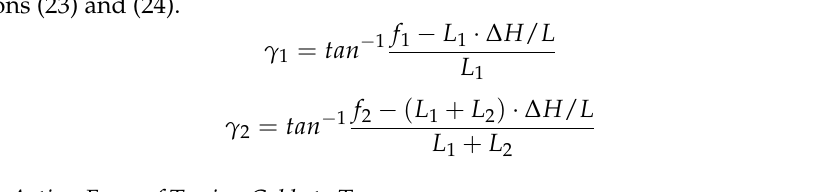
Figure 4. Calculation diagram of the acting force of lifting cable on tower.